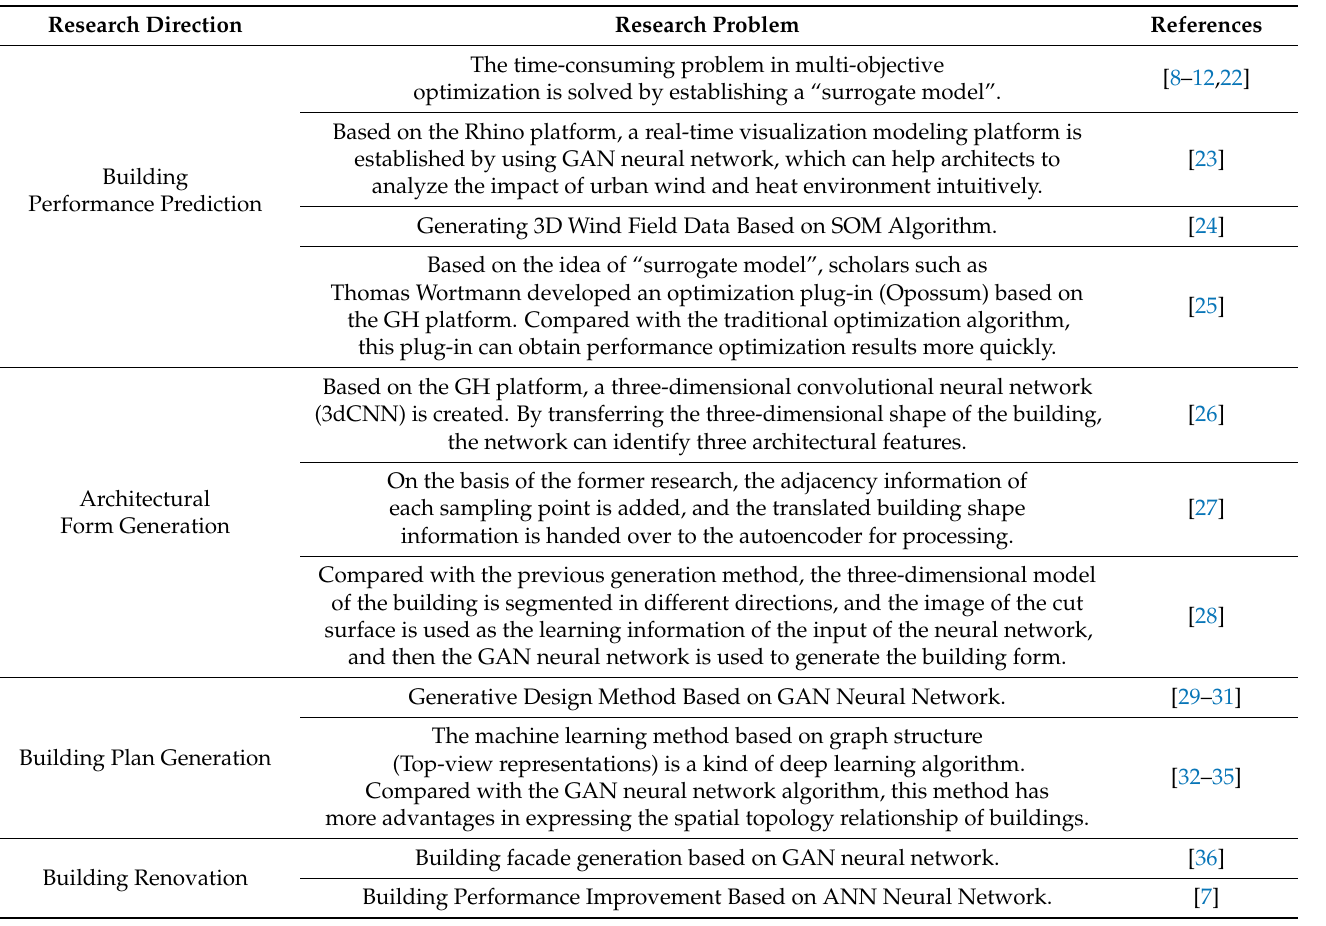
Table 2. The development of research problems in the application of machine learning in architectural